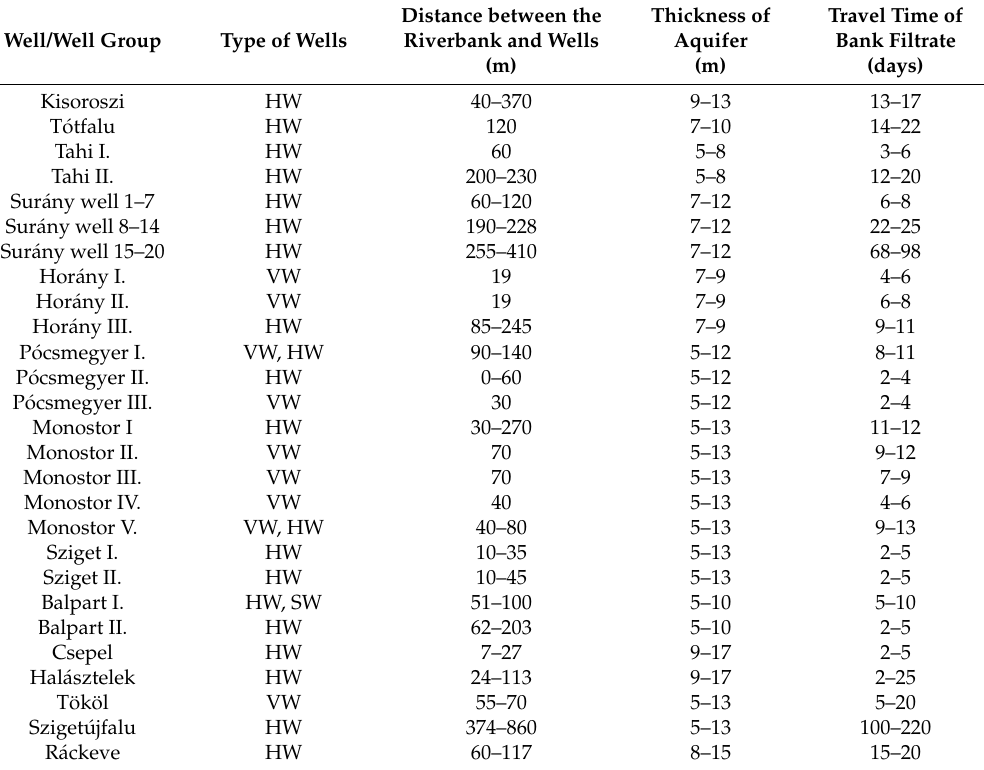
Table 1. Distance and travel time between the Danube River and RBF wells in